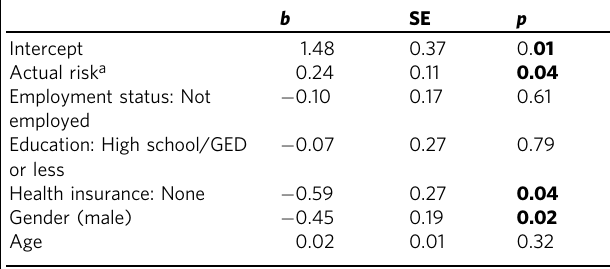
Table 2 Generalized linear models predicting the